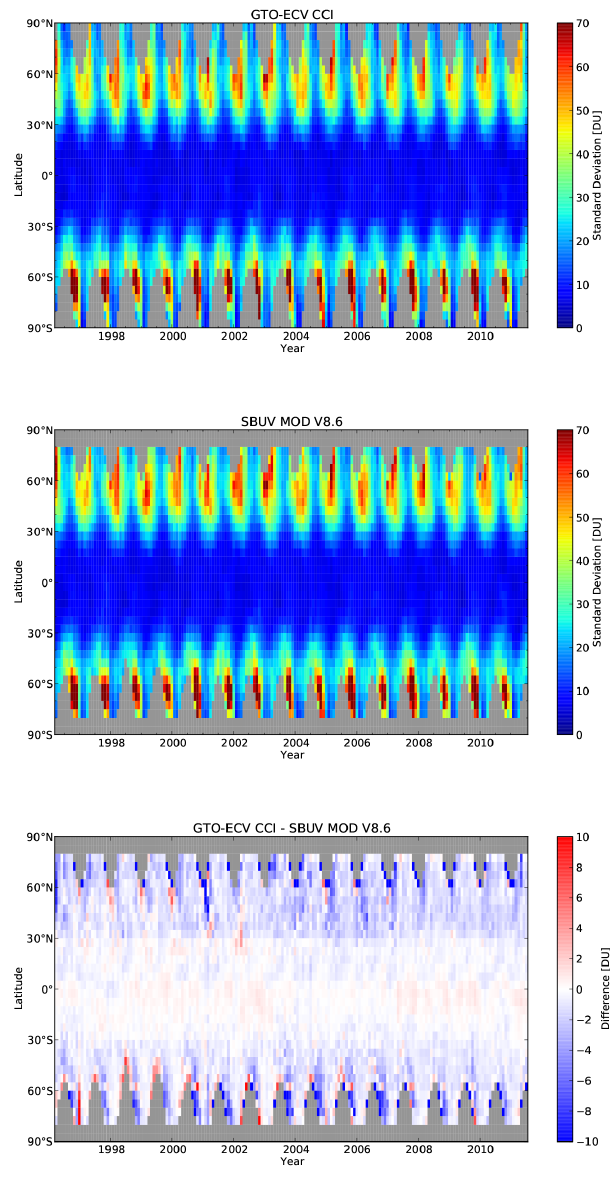
Figure 16. Standard deviation of 5 ◦ monthly mean ozone columns as a function of latitude and time: GTO-ECV CCI (top panel)and SBUV-MOD (middle panel). The bottom panel shows the absolute difference between GTO-ECV CCI and SBUV-MOD standard de-